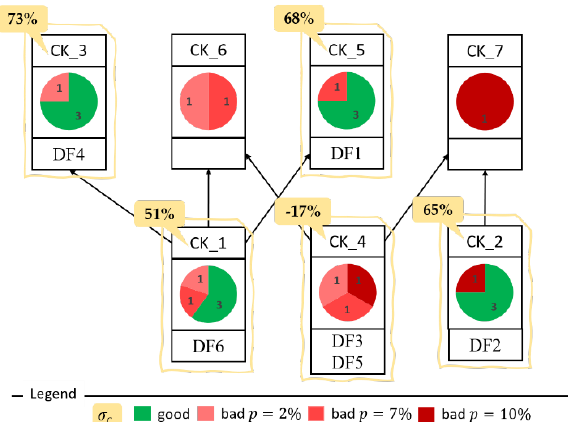
Figure 5. An excerpt of the simplified version of 𝐿 𝐾 (built from Table 1) where the most specific concepts are annotated with their satisfaction degrees 𝜎 𝑐 . The intent relies on a more user-friendly visualisation (i.e., pie chart) to engage managers.